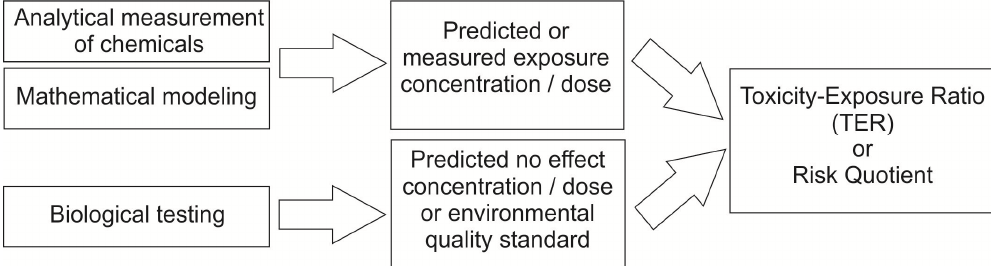
Figure 2. Determination of toxicity-exposure ratios (TER) or risk quotients by combining data on exposure scenarios with expected biological effects and/or environmental